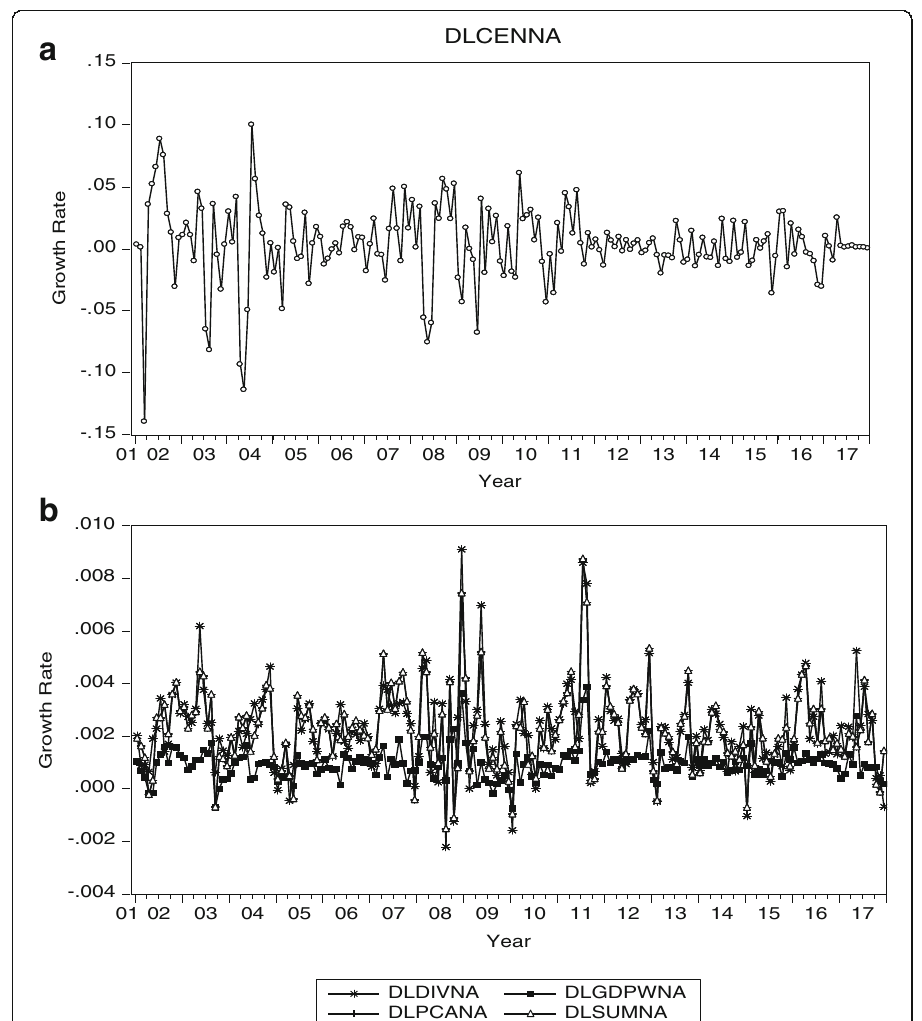
Fig. 5 a Monthly Growth Rate of the CE Monetary Aggregate of North America. DLCENNA is log differences of CE measure for North America. The numbers 01 through 17 on the horizontal axis represent the years 2001 through 2017 respectively b Monthly Growth Rates of Monetary Aggregates (other than CE) of North America. DLDIVNA, DLGDPWNA, DLPCANA and DLSUMNA are log differences of Divisia index, GDP- weighted, PCA-based, and Simple-Sum measures for North America respectively. The numbers 01 through 17 on the horizontal axis represent the years 2001 through 2017